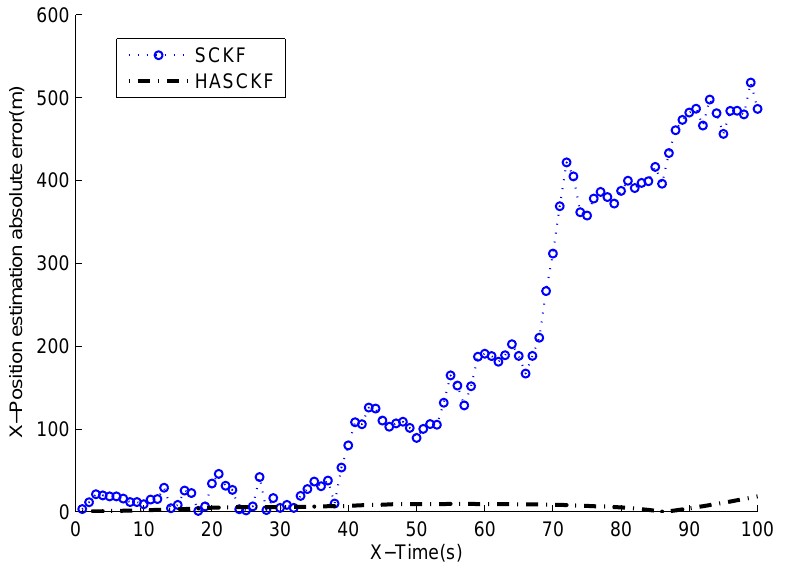
Figure 7. Absolute error curves of